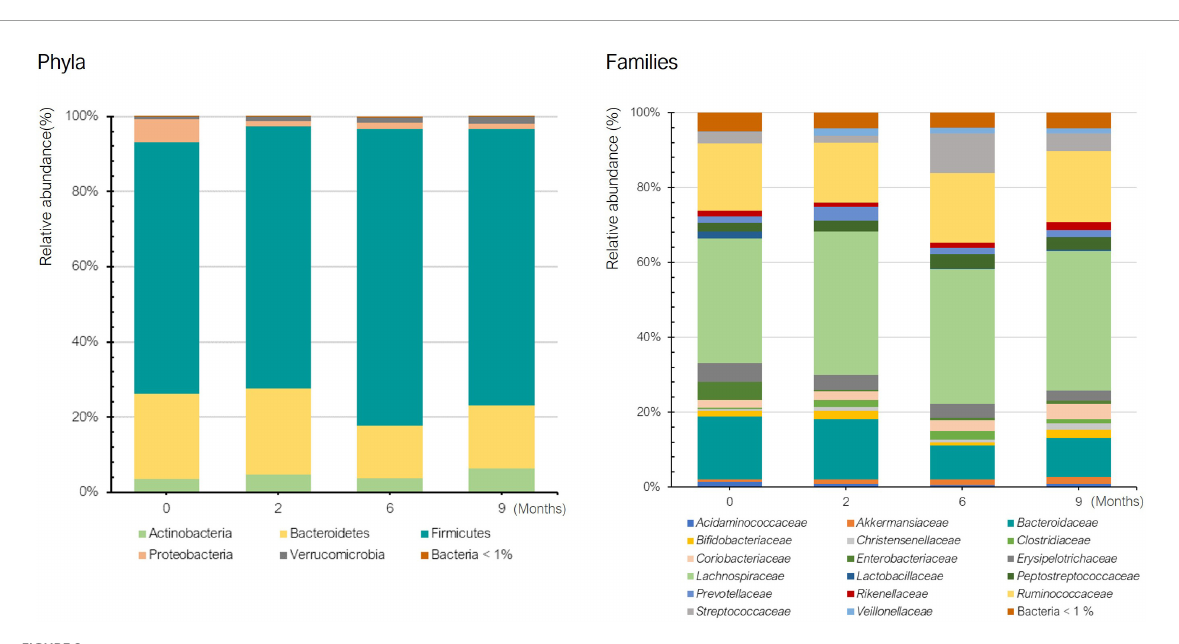
FIGURE2 Relative abundance (%) of bacteria at phylum and family levels in histamine intolerant patients during the 9-month dietary